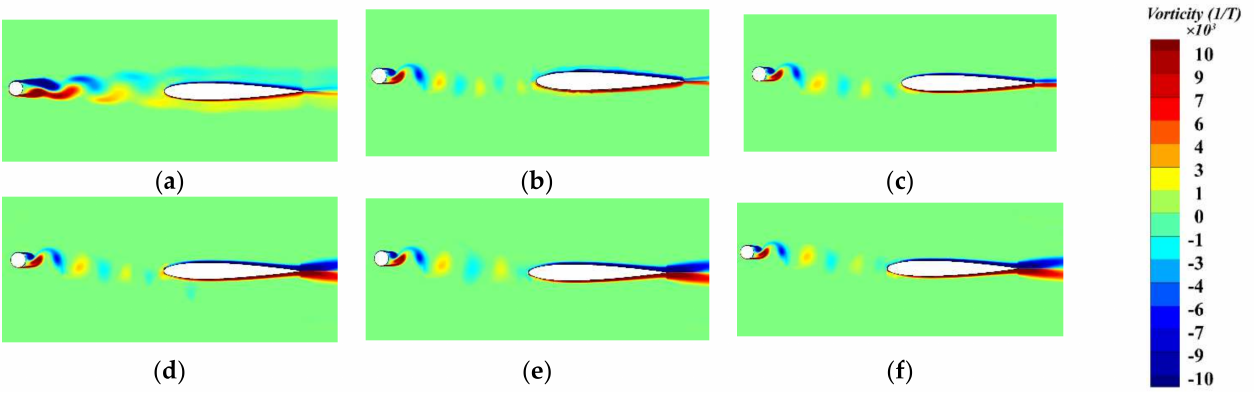
Figure 17. Vorticity contours for different cases of A/C: ( a ) A/C = 0, ( b ) A/C = 0.02, ( c ) A/C = 0.04, ( d ) A/C = 0.06, ( e ) A/C = 0.08, ( f ) A/C =